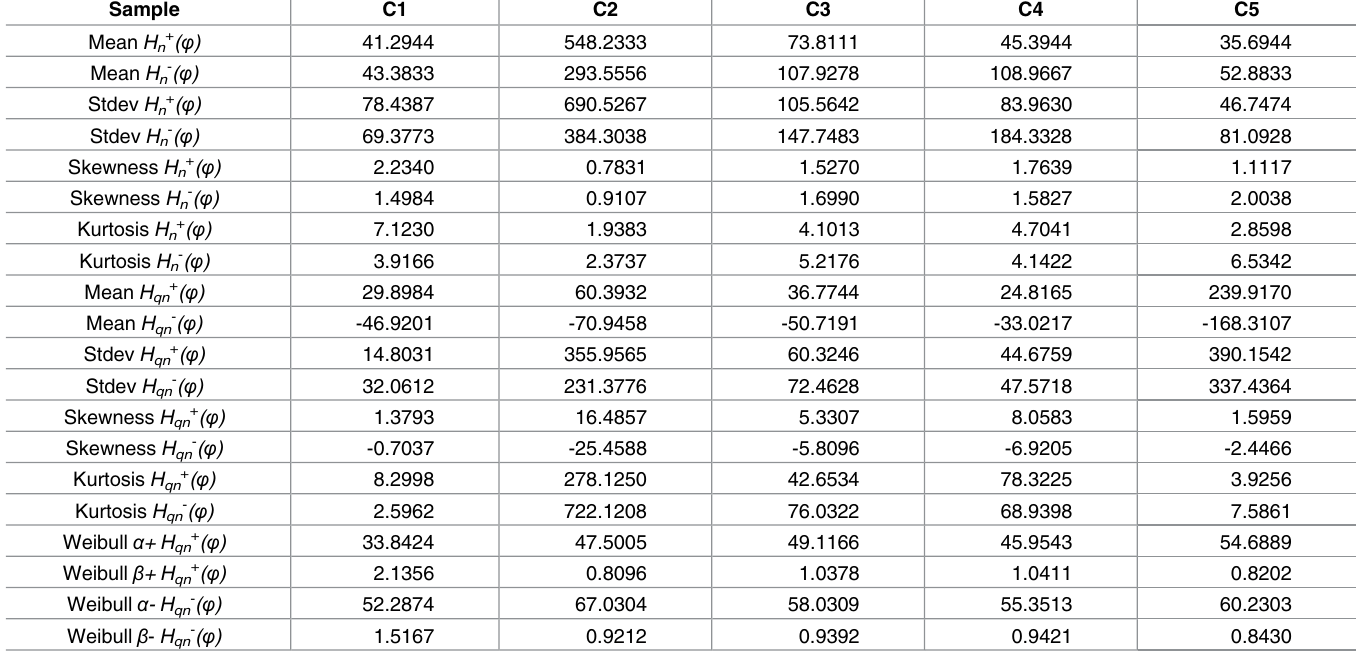
Table 2. Extracted statistical features.